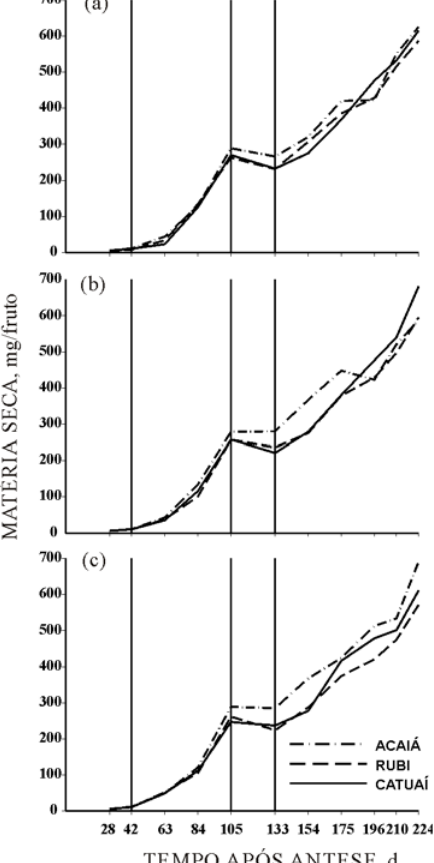
Figura 1. Acúmulo médio de matéria seca em frutos de cafeeiro durante o período reprodutivo, nos níveis baixo (a), adequado (b) e alto (c) de adubação. As linhas verticais delimitam os estádios de desenvolvimento dos frutos de chumbinho, expansão rápida, crescimento suspenso e